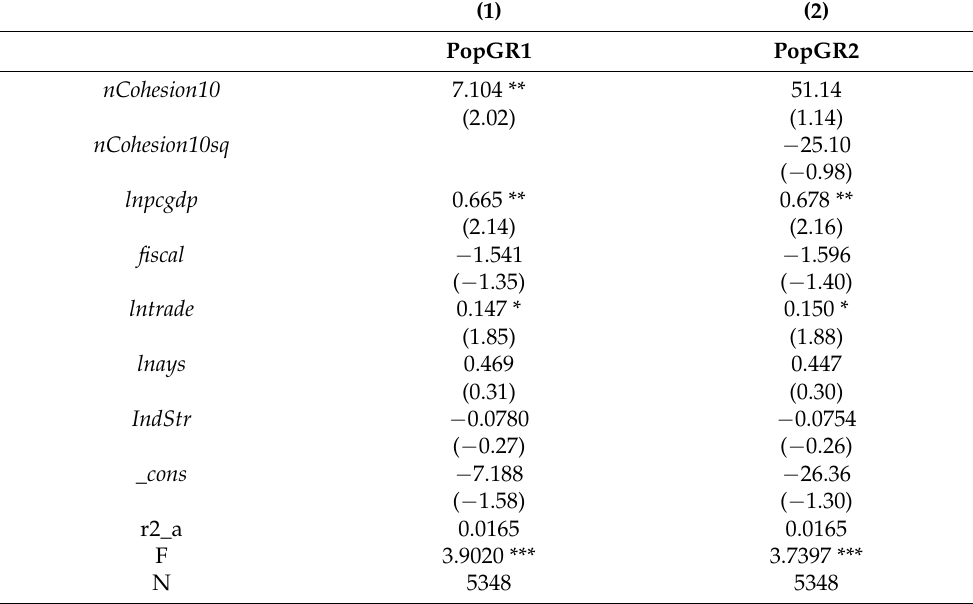
Table 4. Mechanism tests: impact of city shape on population